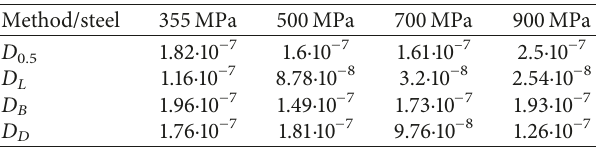
Table 2: Average values of diffusion coefficients (cm 2 /s) for test materials calculated using the four